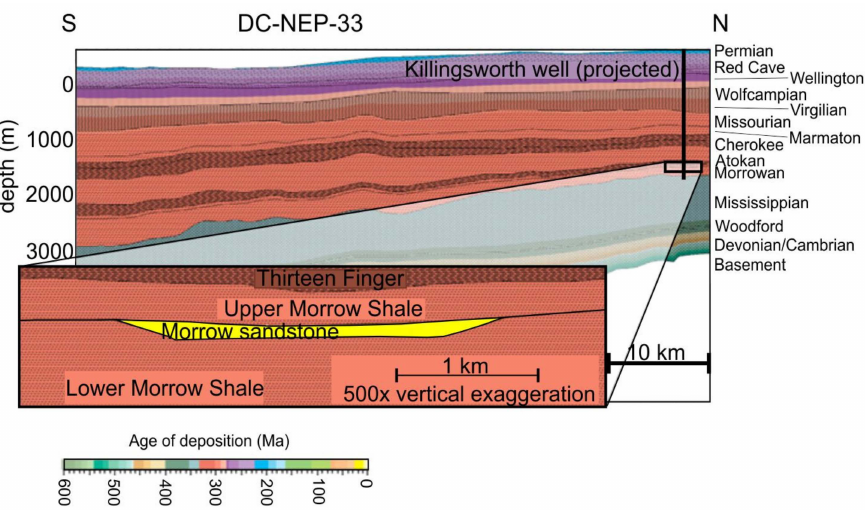
Figure 14. Details of seismic line DC-NEP-33 (location in Figure 2) with a Morrowan sandstone layer (yellow) that is encased in shale (light red). The projected location of the Killingsworth well is marked. Geometry of the sand body is based on well logs and average reservoir dimensions (see text for discussion). Colors correspond to the age of deposition, except for the Morrow sandstone, which is of Morrowan